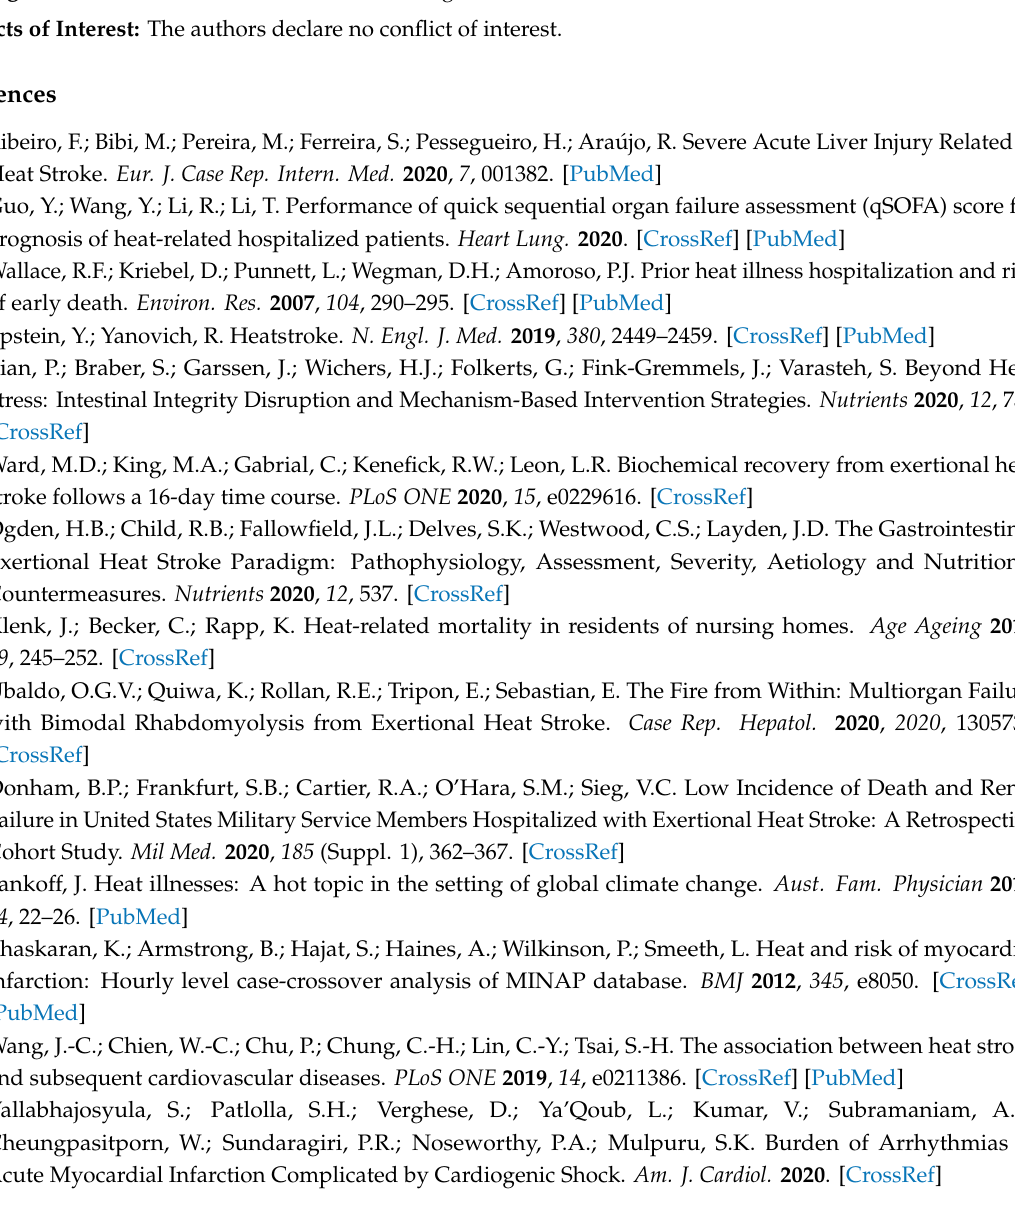
Table S1: ICD-9 code for patient characteristics, treatments, and